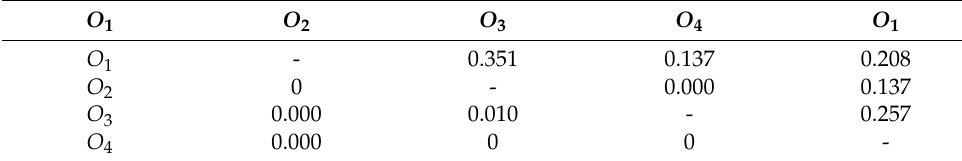
Table 7. The modified total matrix.